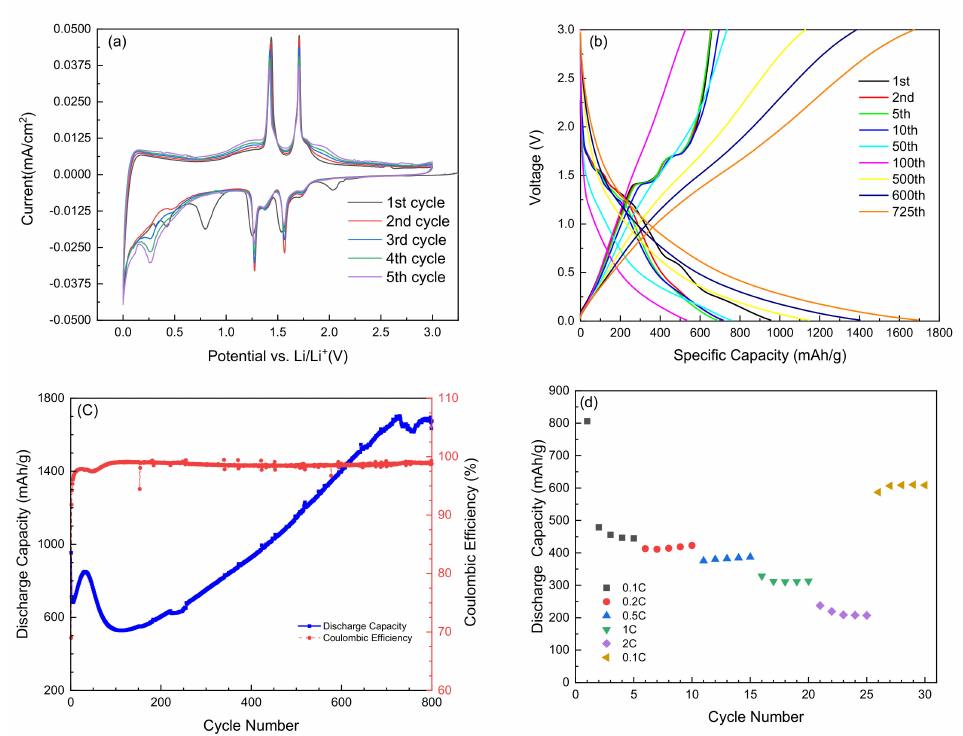
Figure 8. Electrochemical performance of MOV as anode material. ( a ) First five cyclic voltammograms recorded at scanning rate of 0.01 mV s − 1 . ( b ) Galvanostatic charge/discharge curves of MoO 2 performed at 1C-rate (~0.86 A g − 1 ). ( c ) Specific discharge capacity and Coulombic efficiency as a function of cycle number performed at 1C-rate. ( d ) Rate